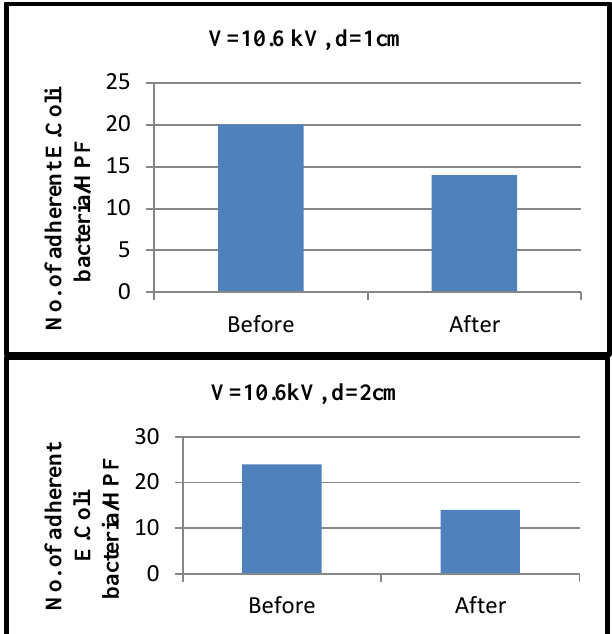
Figure (7): Mean values of No. of adherent E.Coli bacteria to epithelial cells before & after treatment with plasma needle. Increasing applied voltage, treatment time and decreasing distances between plasma needle and substance, effect on decreasing No. of bacteria attached to epithelial cells on E.Coli